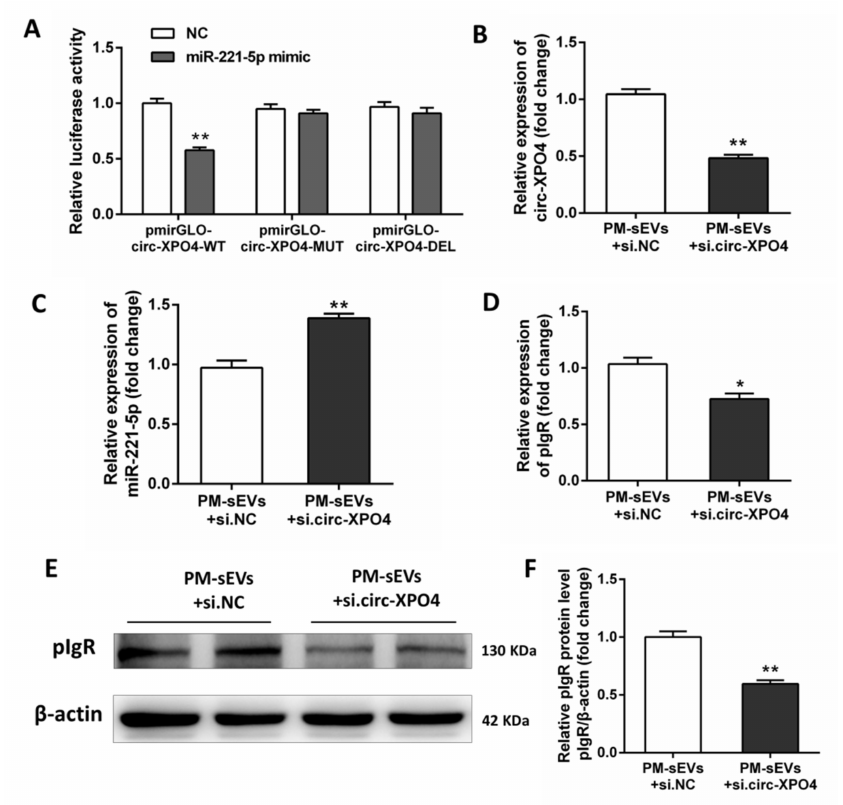
Figure 5. PM-sEVs circ-XPO4 regulates the miR-221-5p/pIgR pathway in IPEC-J2 cells. ( A ) Dual luciferase reporter system detect the targeting relationship between miR-221-5p and circ-XPO4 ( n = 8). ( B – D ) qRT-PCR analysis of circ-XPO4, miR-221-5p, and pIgR expression levels in IPEC-J2 cell treated with PM-sEVs + si.NC or PM-sEVs + si.circ-XPO4 ( n = 6). ( E , F ) Western Blotting analysis of pIgR protein levels in IPEC-J2 cell treated with PM-sEVs + si.NC or PM-sEVs + si.circ-XPO4 ( n = 4). * p < 0.05; ** p < 0.01.